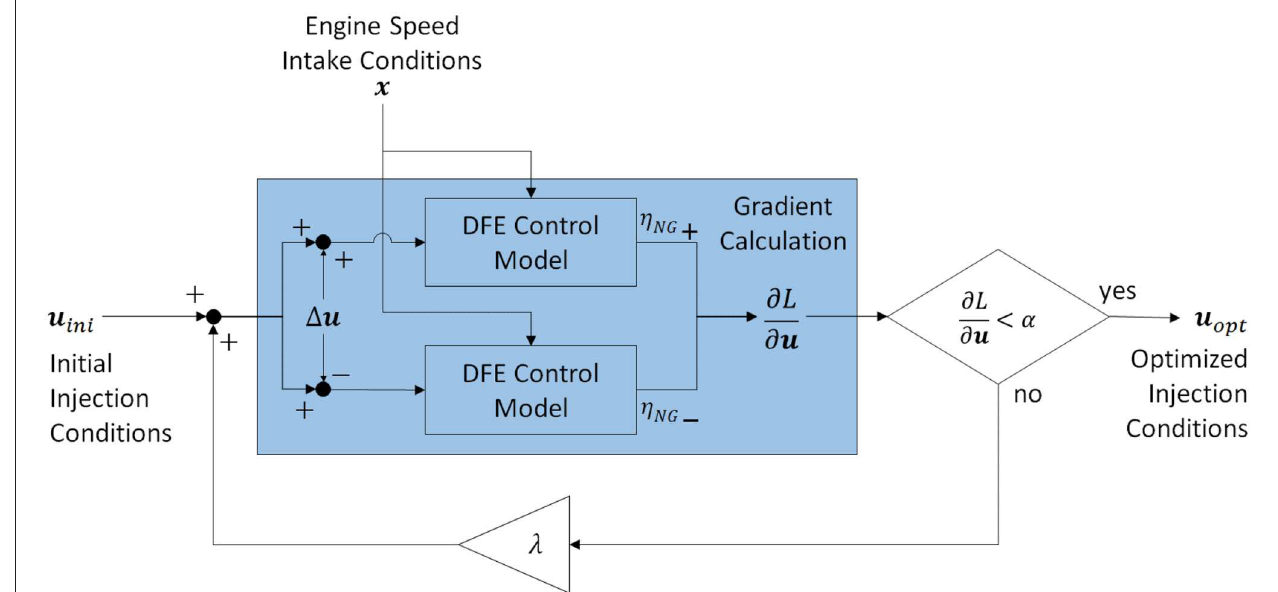
FIGURE 7 | Controller